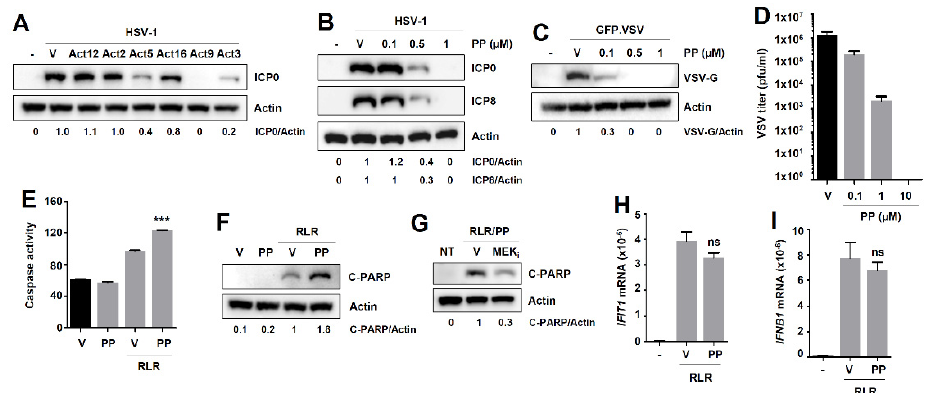
Figure 8. Another RIPA-promoting drug, pyrvinium pamoate, is antiviral against VSV and HSV-1, without affecting IFN and ISG production. ( A ) HT1080 cells were infected with HSV-1 in the absence or the presence of the selected RIPA-promoters (Act12, Act2, Act5, Act16, Act9, and Act3). Viral protein ICP0 was analyzed by immunoblot 24 h post-infection. ( B ) HT1080 cells were infected with HSV-1 in the absence or the presence of pyrvinium pamoate (PP, at the indicated doses) and expression of viral proteins (ICP0 and ICP8) was analyzed by immunoblot 24 h post-infection. ( C ) HT1080 cells were infected with GFP.VSV in the absence or presence of pyrvinium pamoate (PP, at the indicated doses), and VSV-G protein expression was analyzed by immunoblot 24 h post-infection. ( D ) HT1080 cells were infected with GFP.VSV in the absence or presence of pyrvinium pamoate (PP, at the indicated doses), and virus titer was determined via plaque assay in Vero cells 24 h post-infection. ( E , F ) HT1080 cells were transfected with polyI:C (RLR) in the absence or the presence of pyrvinium pamoate, and caspase-3 activity ( E ) and C-PARP ( F ) were measured 16 h post-RLR. ( G ) HT1080 cells were transfected with polyI:C (RLR) in the presence of pyrvinium pamoate, and treated with either vehicle (V) or the inhibitor of MEK (MEK i ), and C-PARP was analyzed 16 h post-RLR. ( H , I ) HT1080 cells were transfected with polyI:C (RLR) in the absence or the presence of pyrvinium pamoate, and the mRNA expression of IRF3-dependent genes IFIT1 ( H ) and IFNB1 ( I ) were analyzed by qRT-PCR 8 h post-RLR. Vehicle (V), DMSO treatment, *** indicates p < 0.001, ns, not significant ( p > 0.05).